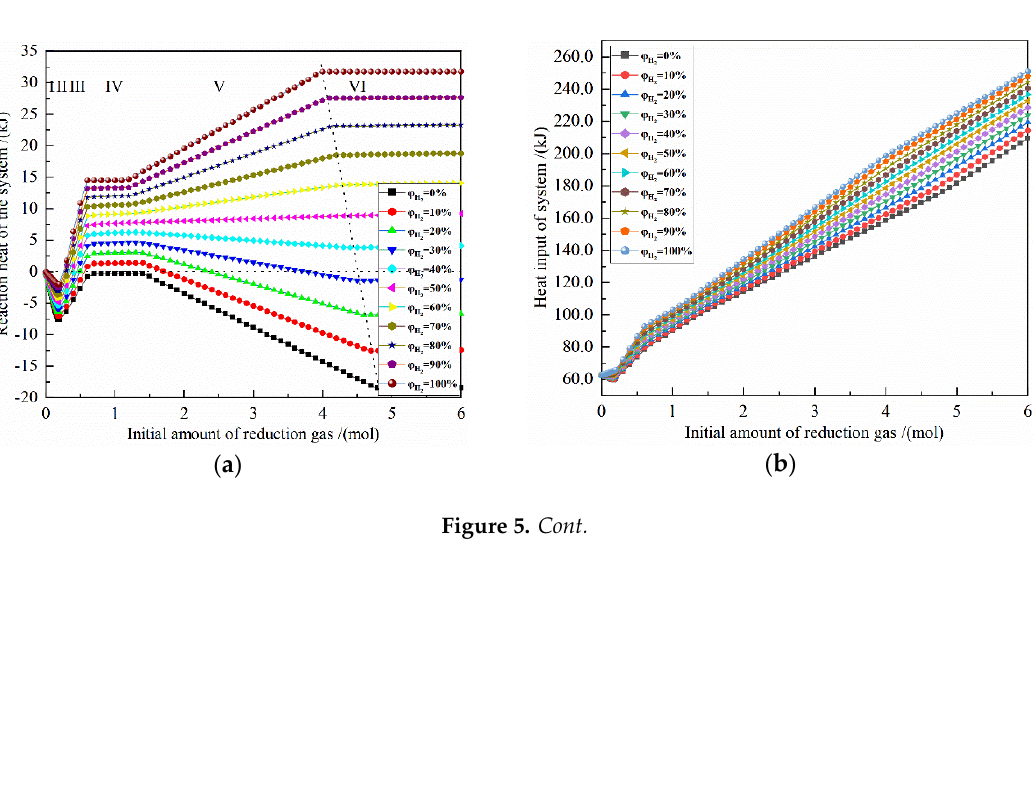
Figure 4. The effect of the initial amount of reduction gas on gas utilization rate in the reduction of 0.5 mol Fe 2 O 3 at 900 ° С with varied H 2 concentrations: ( a ) utilization rate of isolated reduction gas; ( b ) utilization rate of H 2 + CO mixture